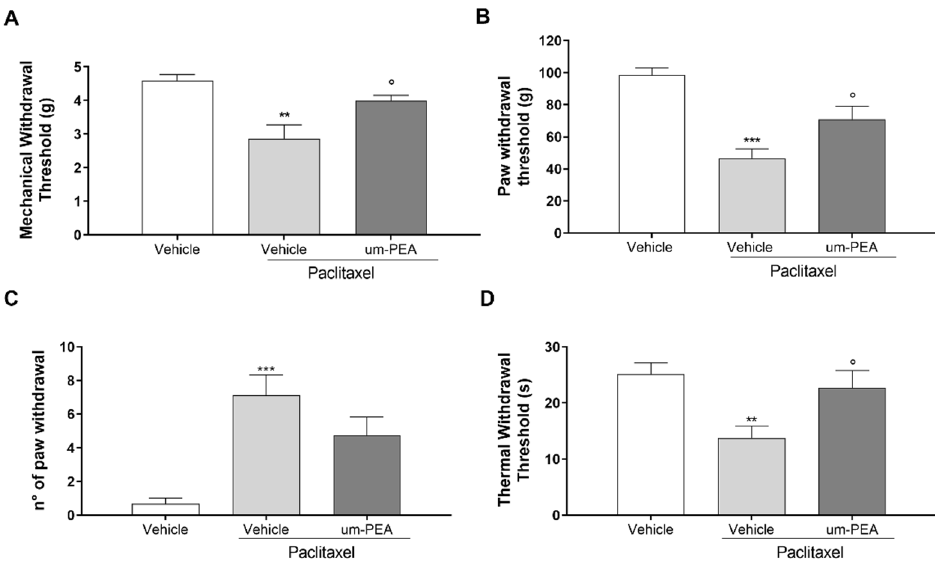
Figure 5. Effect of um-PEA on peripheral neuropathy. Results of the ( A ) von Frey test to evaluate mechanical allodynia; ( B ) Randall–Selitto test to assess mechanical hyperalgesia; ( C ) acetone evaporation test to evaluate thermal allodynia; ( D ) Hargreaves test to evaluate thermal hyperalgesia; ** p < 0.01; *** p < 0.001 versus vehicle group; ° p < 0.05 versus PTX group. Data are presented as mean ± SEM ( n = 8). Differences were evaluated by ANOVA followed by Bonferroni’s post hoc test for multiple comparisons.